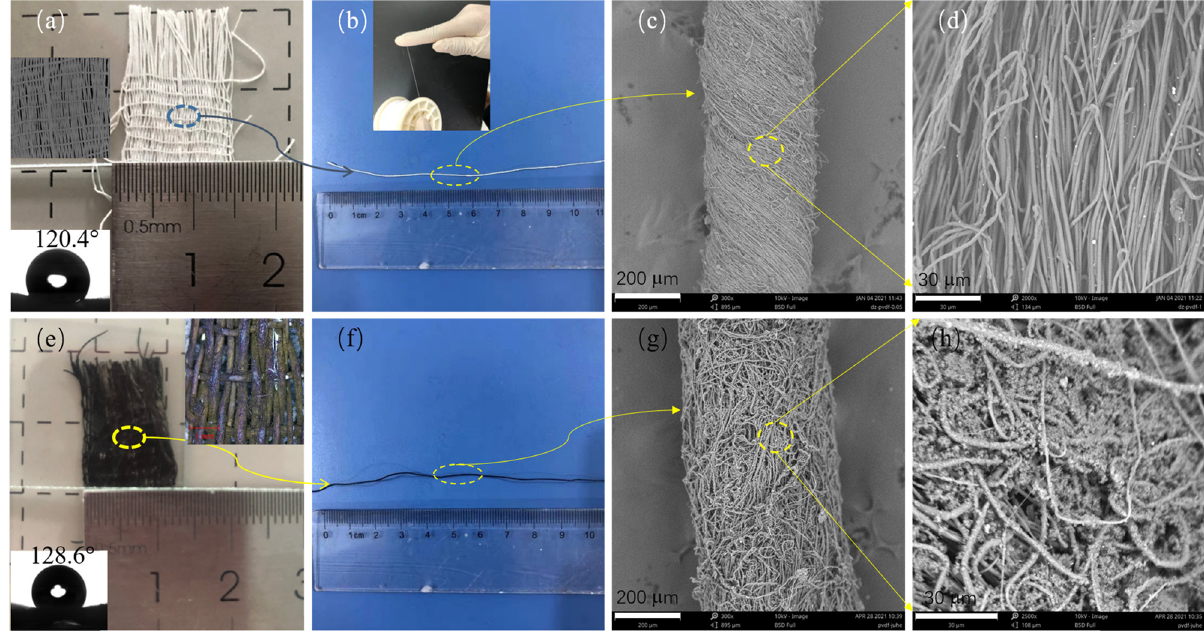
Figure 2: Optical images of ( a ) PVDF fabric and ( b ) yarn, ( c and d ) the SEM images the PVDF yarn, ( e and f ) the optical, and ( g and h ) the SEM images of PANI/PVDF fabric and yarn. Inset images in ( a ) and ( e ) were the contact angles of the